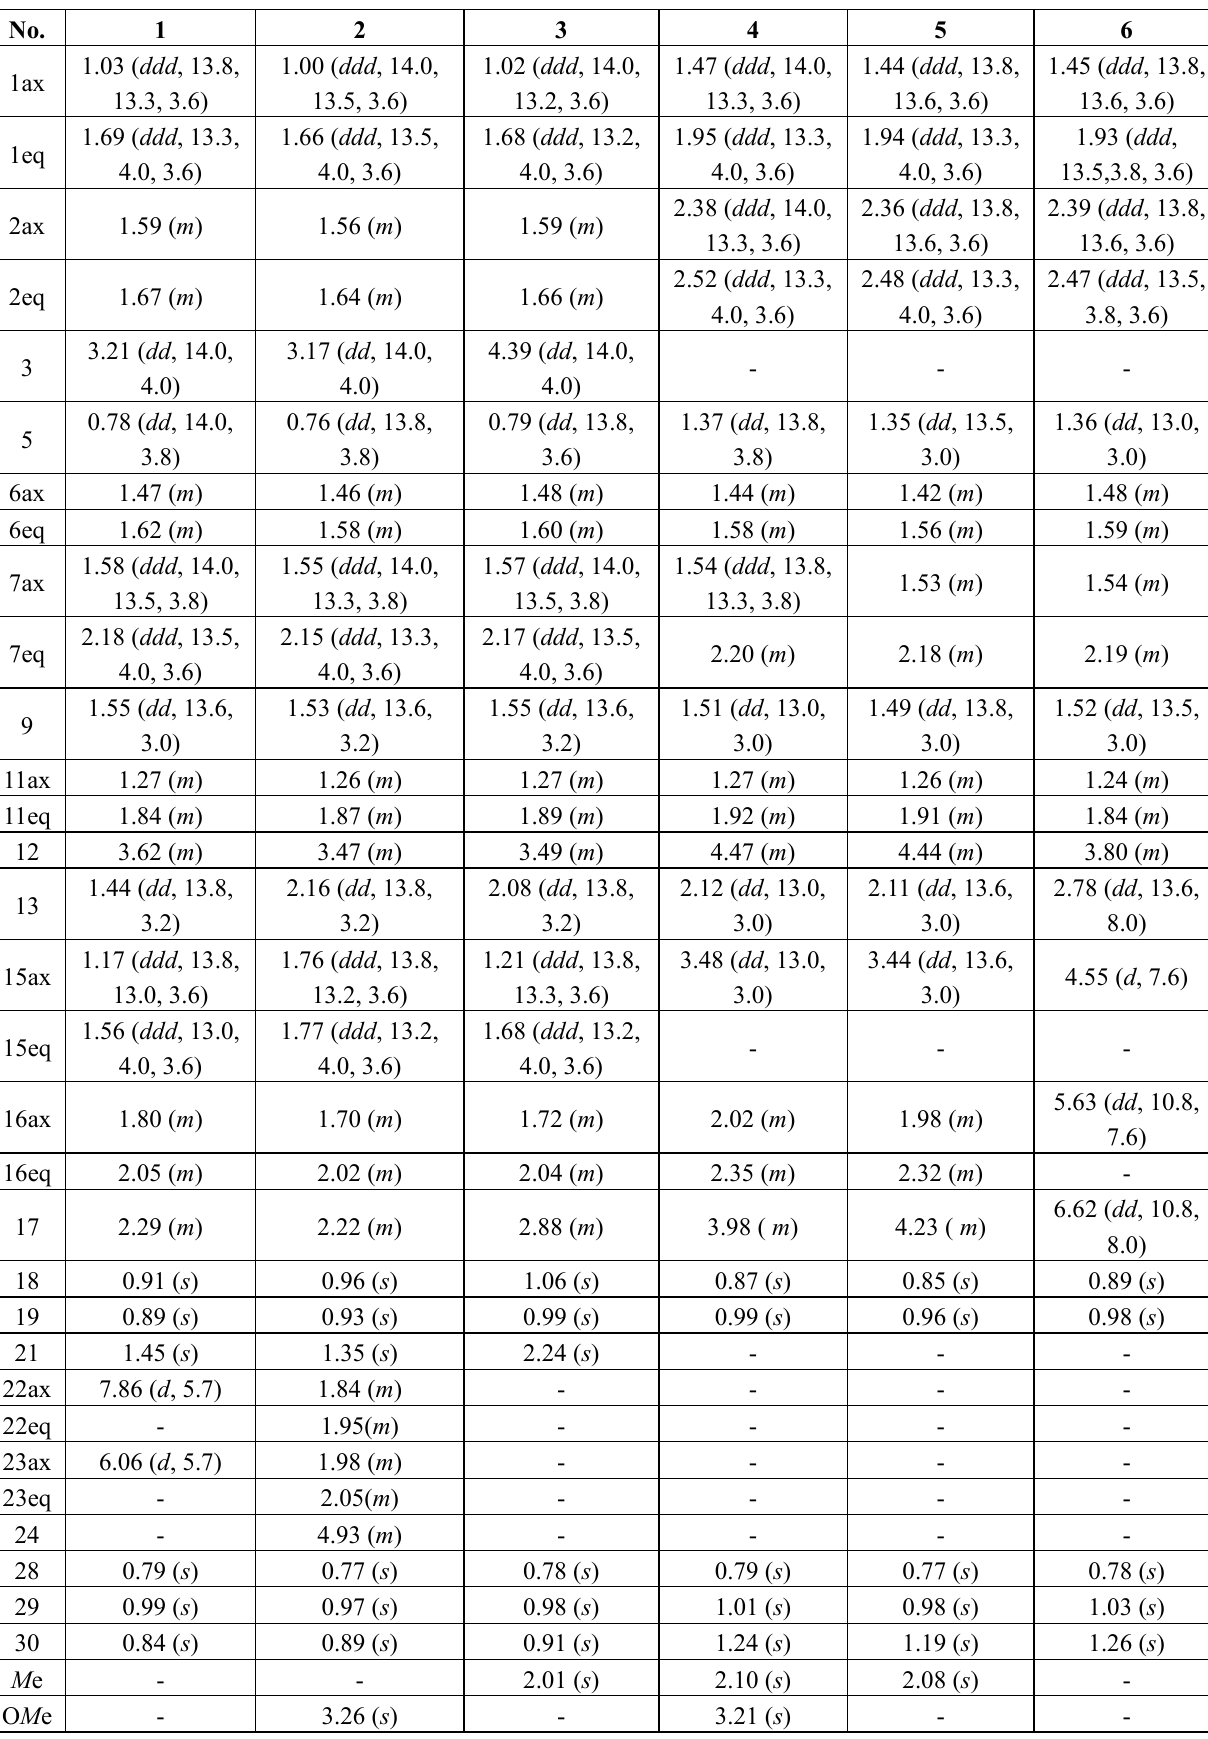
( δ in ppm and J in 3